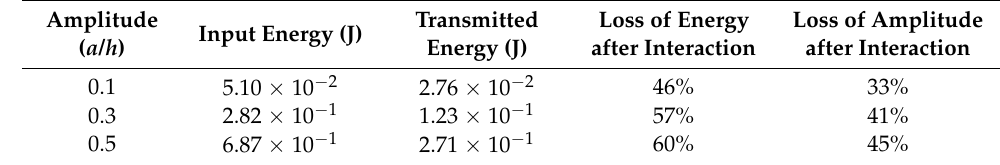
Table 1. Energy analysis results for the solitary wave interacting with a fixed pontoon.